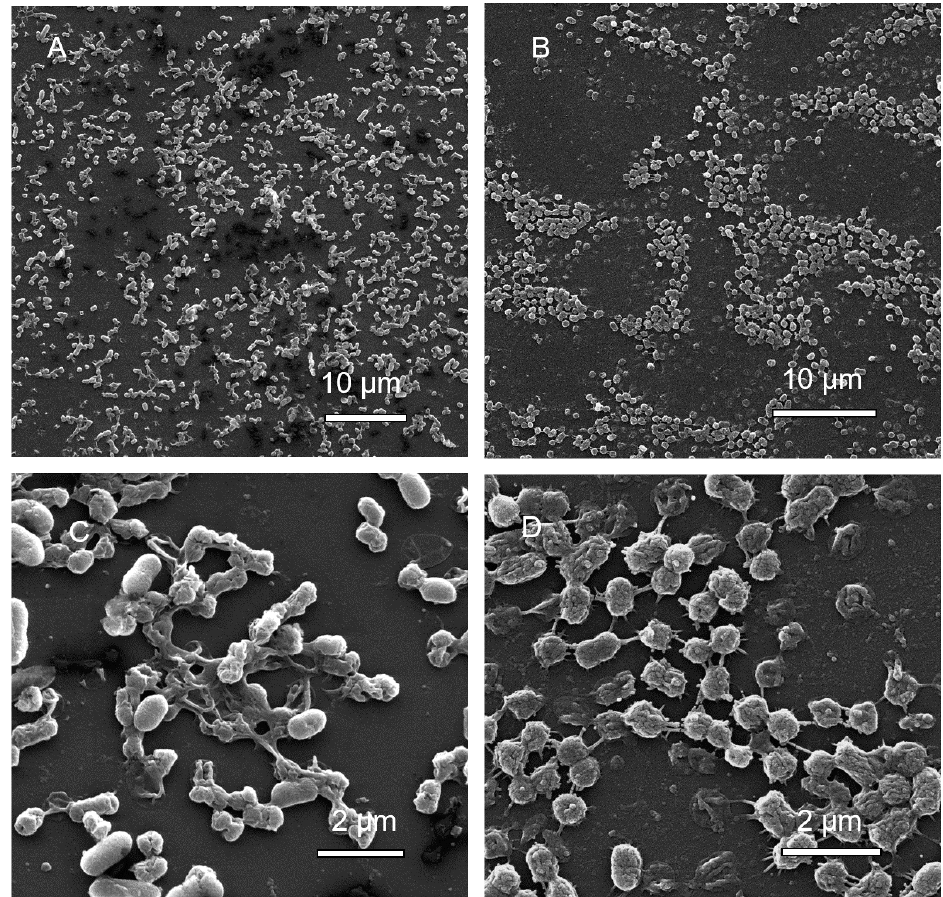
Figure 6. Scanning electron micrographs of C. portucalensis biofilm inoculation pegs at ( A ) the lowest (7.8 μ g/mL) and ( B ) the highest (1000 μ g/mL) concentrations of cotrimoxazole. The images were magnified 3380 × and 4430 × , respectively. ( C ) (18,700 × ), and ( D ) (21,300 × ), show further magnification of cells in (A,B), which received the lowest and highest cotrimoxazole concentrations, respectively.